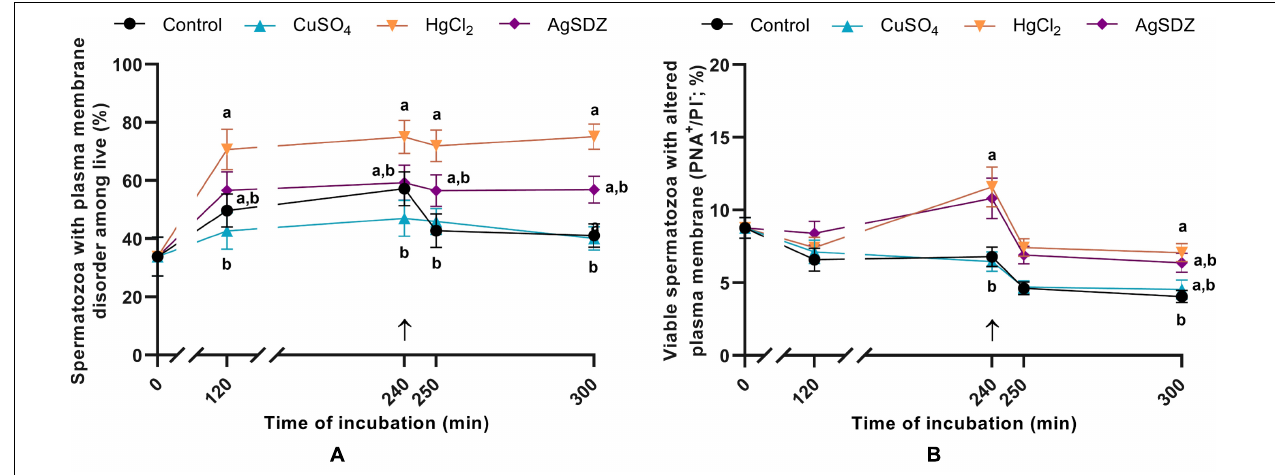
FIGURE 3 | Sperm plasma and acrosome membranes status. (A) Percentages of sperm cells with high membrane lipid disorder within the viable sperm population (%) and (B) percentages of viable spermatozoa with altered integrity of acrosome membrane (%) in samples exposed to the presence or absence of different AQP inhibitors in the capacitation medium: cooper sulfate (CuSO 4 ), mercury chloride (HgCl 2 ) and silver sulfadiazine (AgSDZ). Data were collected after 0, 120 and 240 min of incubation in capacitation medium. At this point, progesterone was added to capacitation medium (arrow) and data were collected after further 10 min and 60 min of incubation. Data are shown as mean ± SEM, and different letters (a,b) indicate significant differences ( P < 0.05) between different treatments within a given time point.